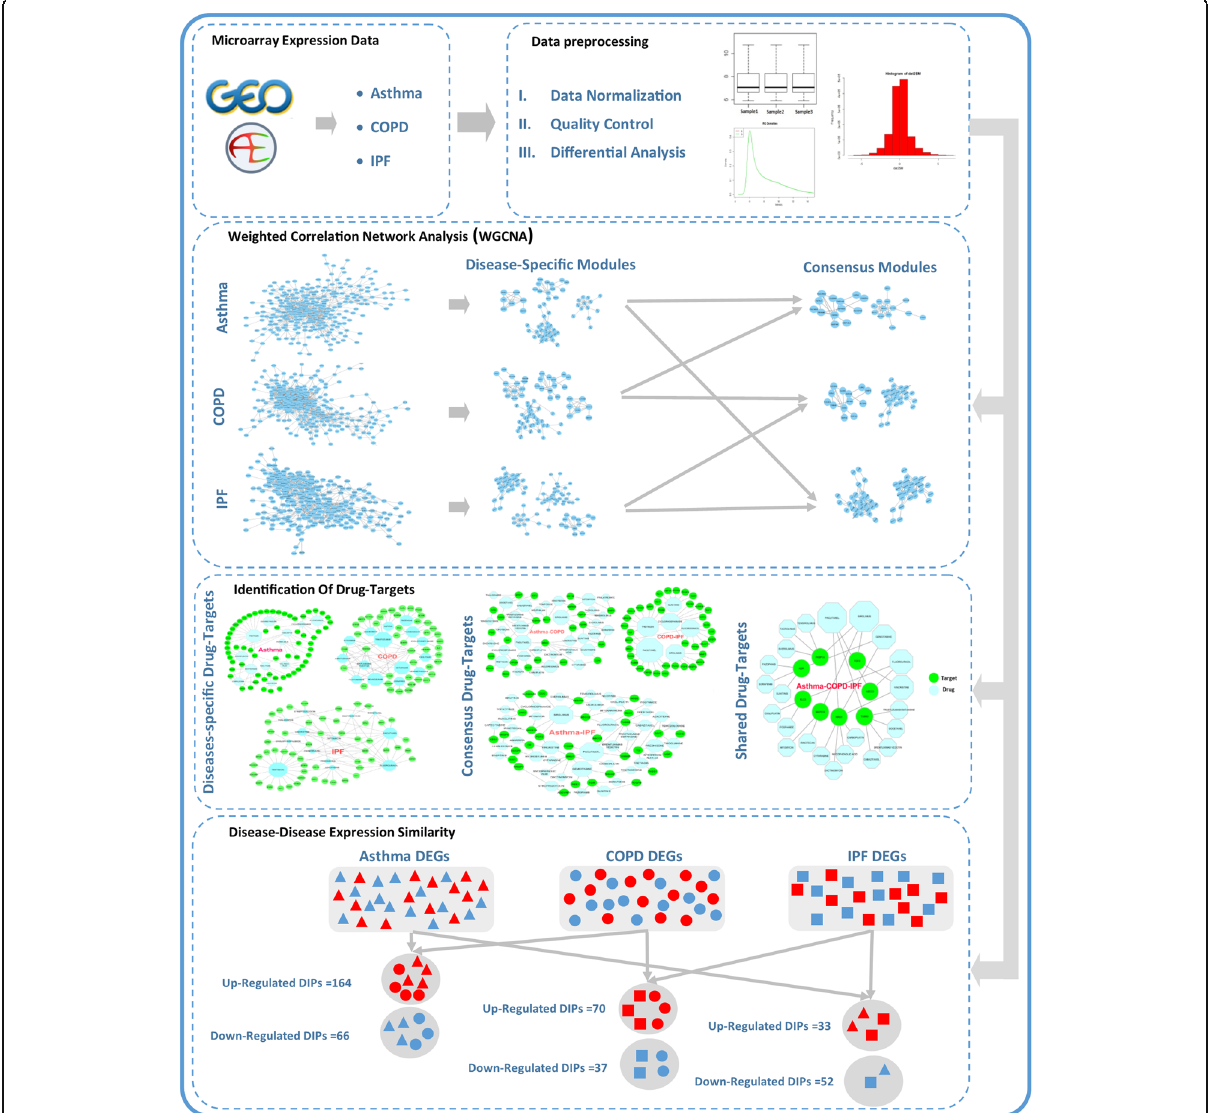
Fig. 1 Workflow of data preparation and